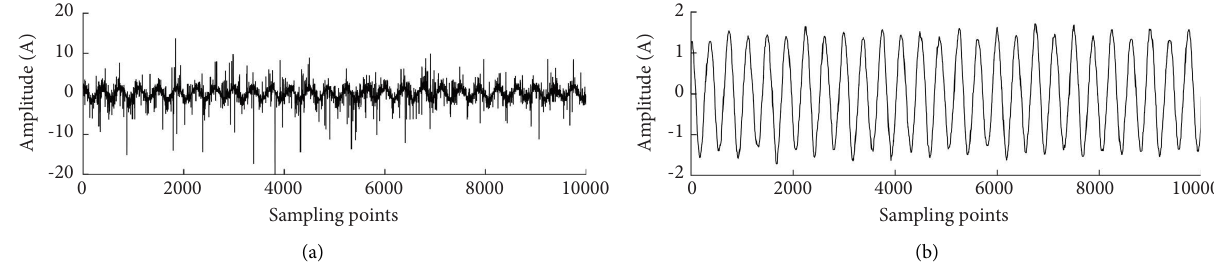
Figure 5: Comparison of current signal before and after fltering. (a) Current signal before fltering. (b) Current signal after fltering.